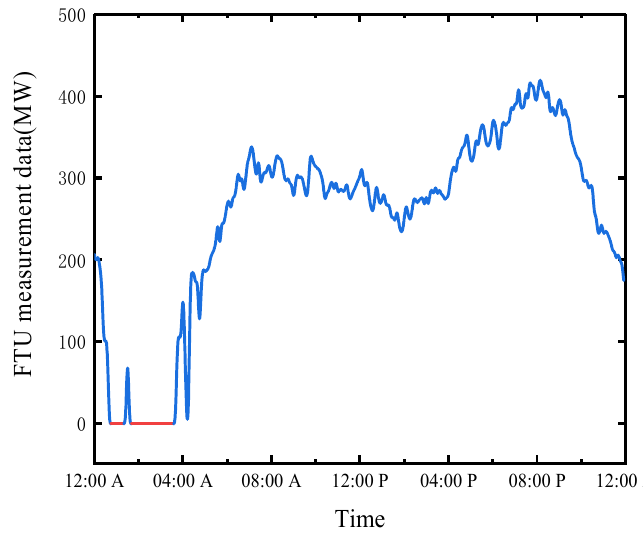
Figure 9. Example of FTU generating data errors.